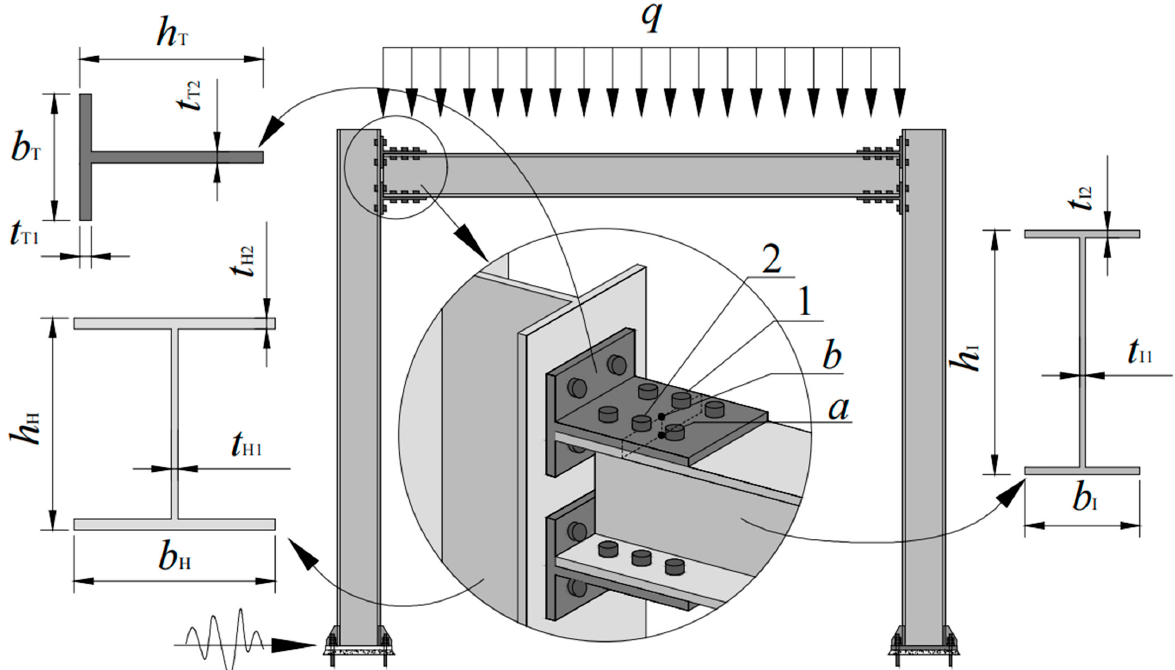
Figure 5. Seismic load application diagram of frame model.